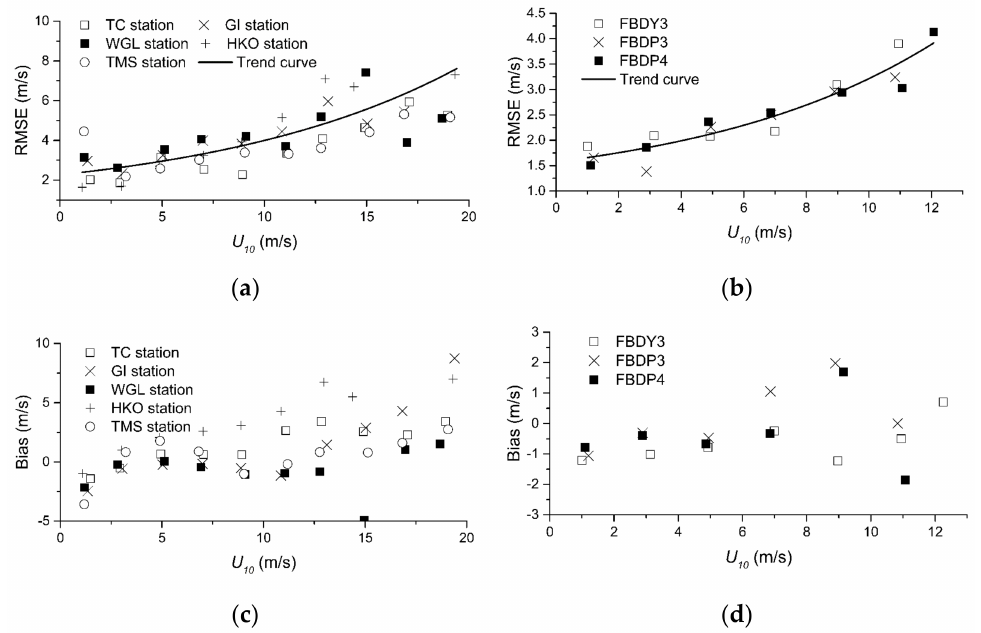
Figure 10. Wind speed error variation as a function of the U 10 . ( a ) RMSE of wind speed over land; ( b ) RMSE of wind speed over the sea; ( c ) Bias of wind speed over land; ( d ) Bias of wind speed over the sea.